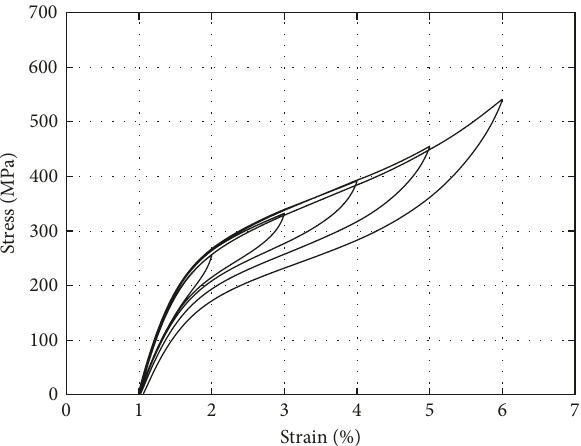
Figure 12: Stress-strain responses under different strain